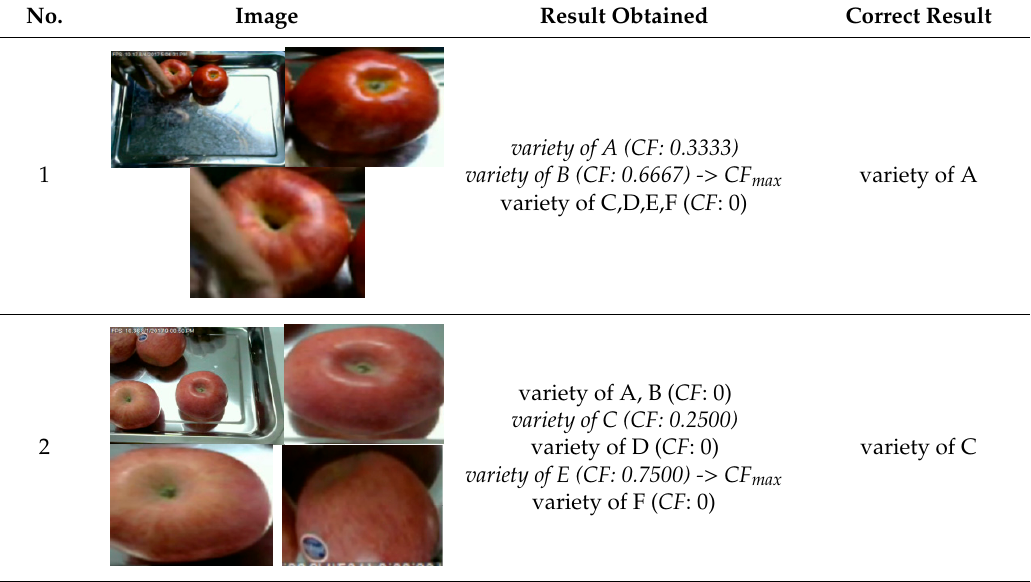
Table 6. Incorrect classification based on the CF max value in the proposed method.